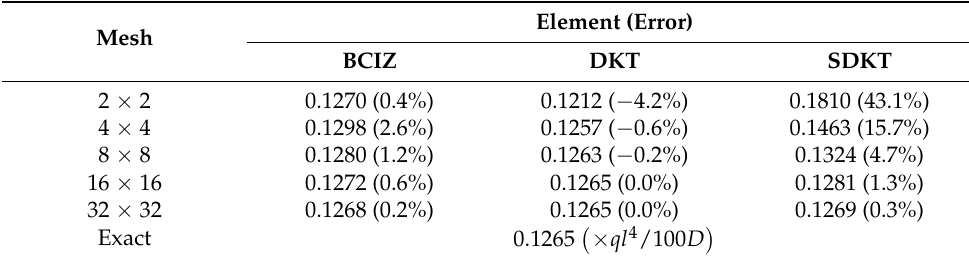
Table 3. Central deflection for a clamped square plate under uniform